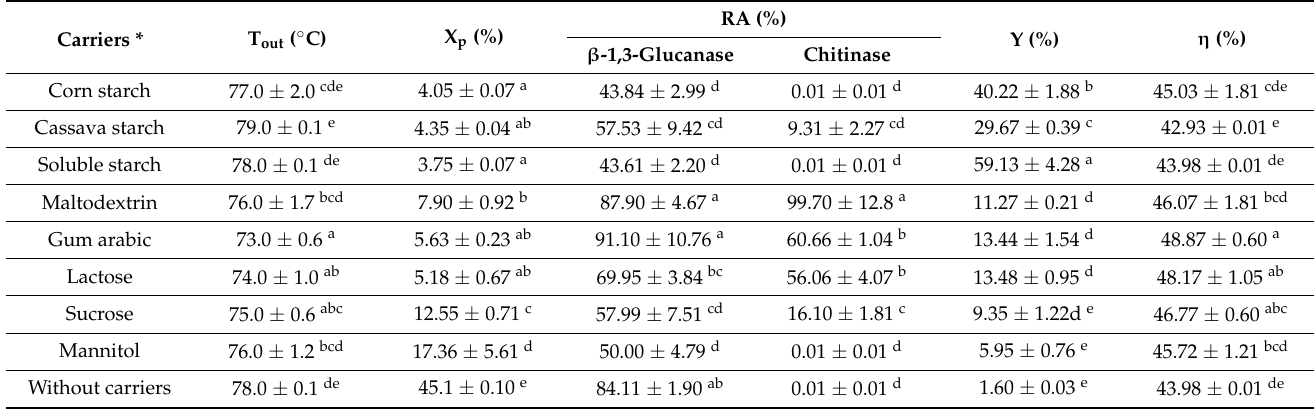
Table 1. Effect of different carriers on the spray drying of enzyme